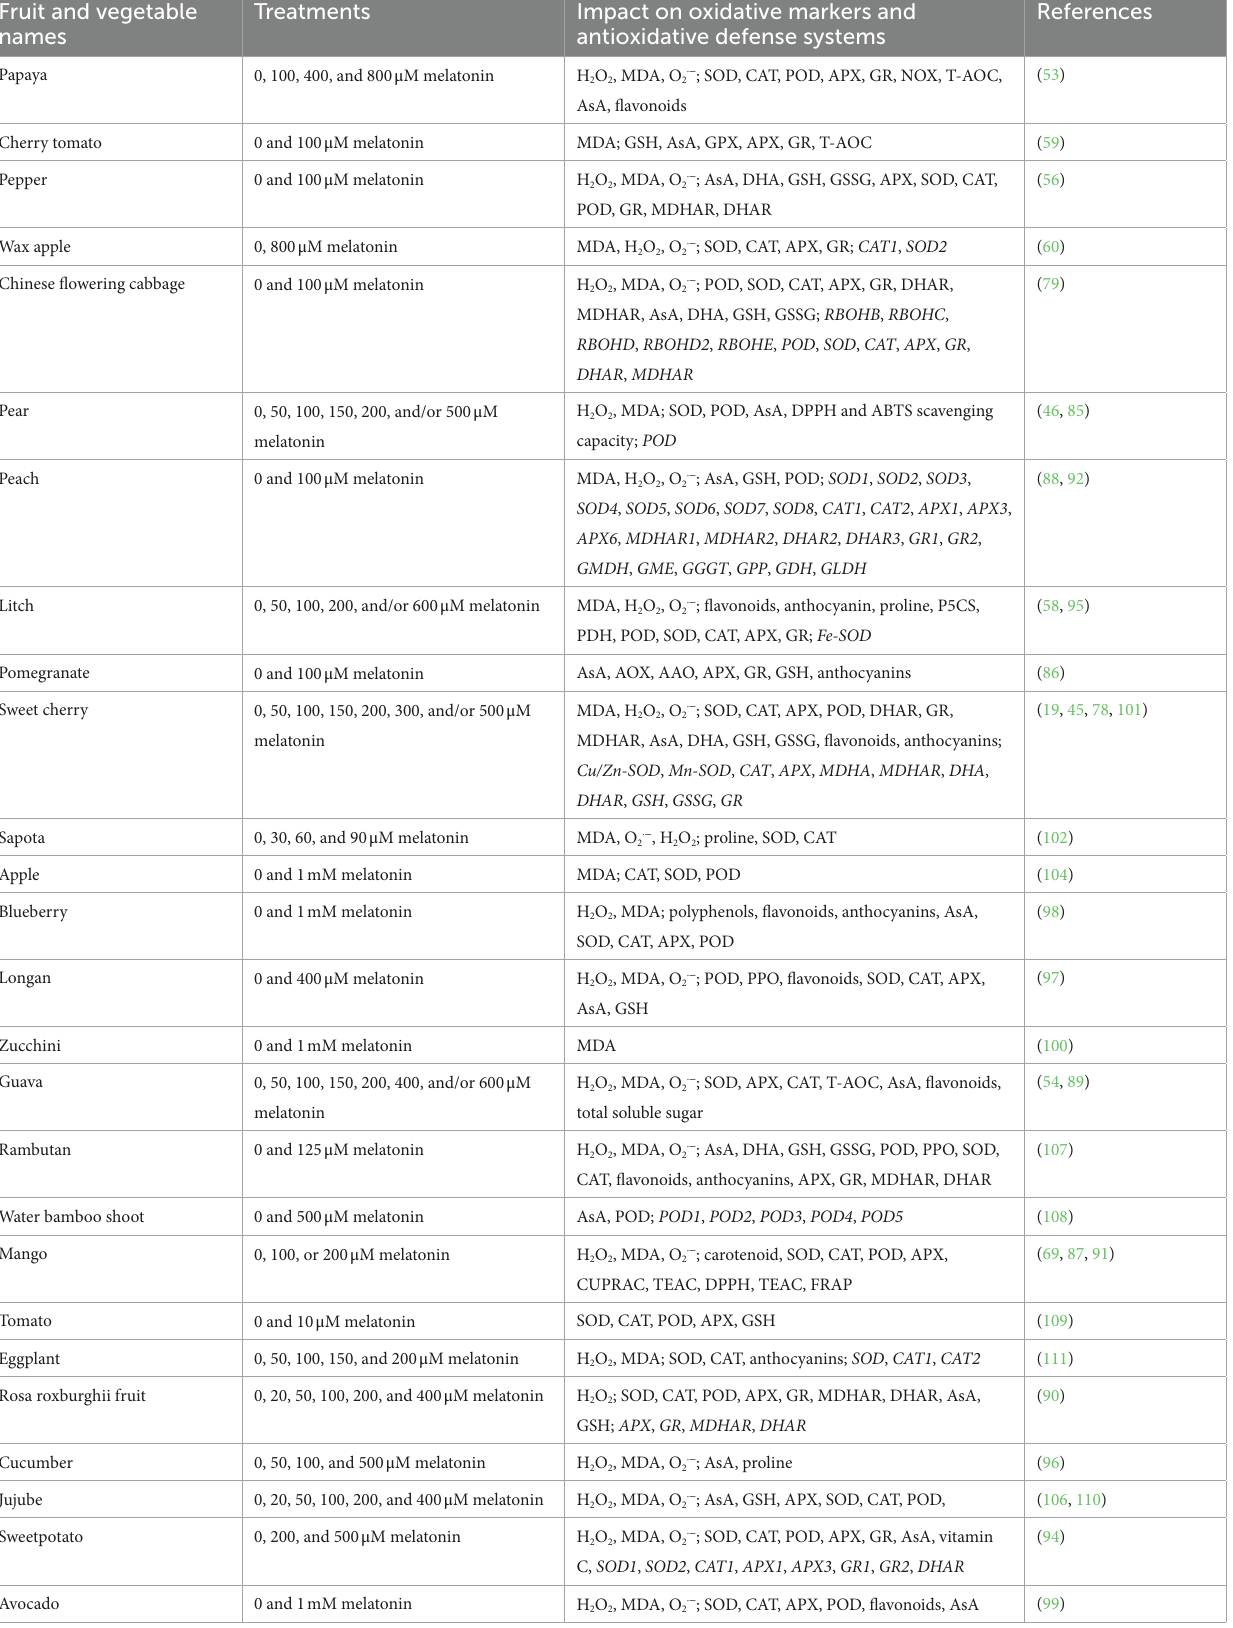
TABLE 2 Summary table explaining the impacts of exogenous melatonin on the antioxidative defense systems of fruits and vegetables during the postharvest period. Fruit and vegetable Treatments Impact on oxidative markers and names antioxidative defense